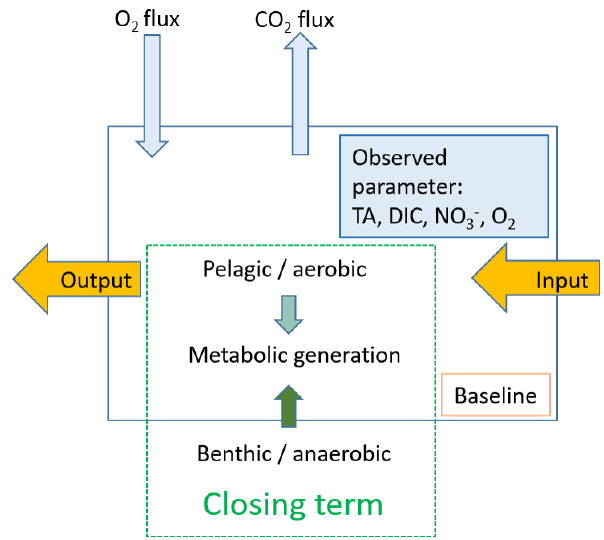
Figure 2. Schematic mass balance approach. We used a box model to balance the net dissolved budgets along the Elbe Estuary. The ob- served parameters are shown in light blue, and the closing term is set as metabolic generation (green), which is fueled by pelagic, i.e., aer- obic, and benthic, i.e., anaerobic, processes but without allocating how much of what is generated where. The input and output is shown in yellow, and the latter acts as the input for the downstream box. To complete DIC and O 2 , we included the atmospheric gas ex- change. The baseline is calculated assuming conservative mixing of fresh and marine